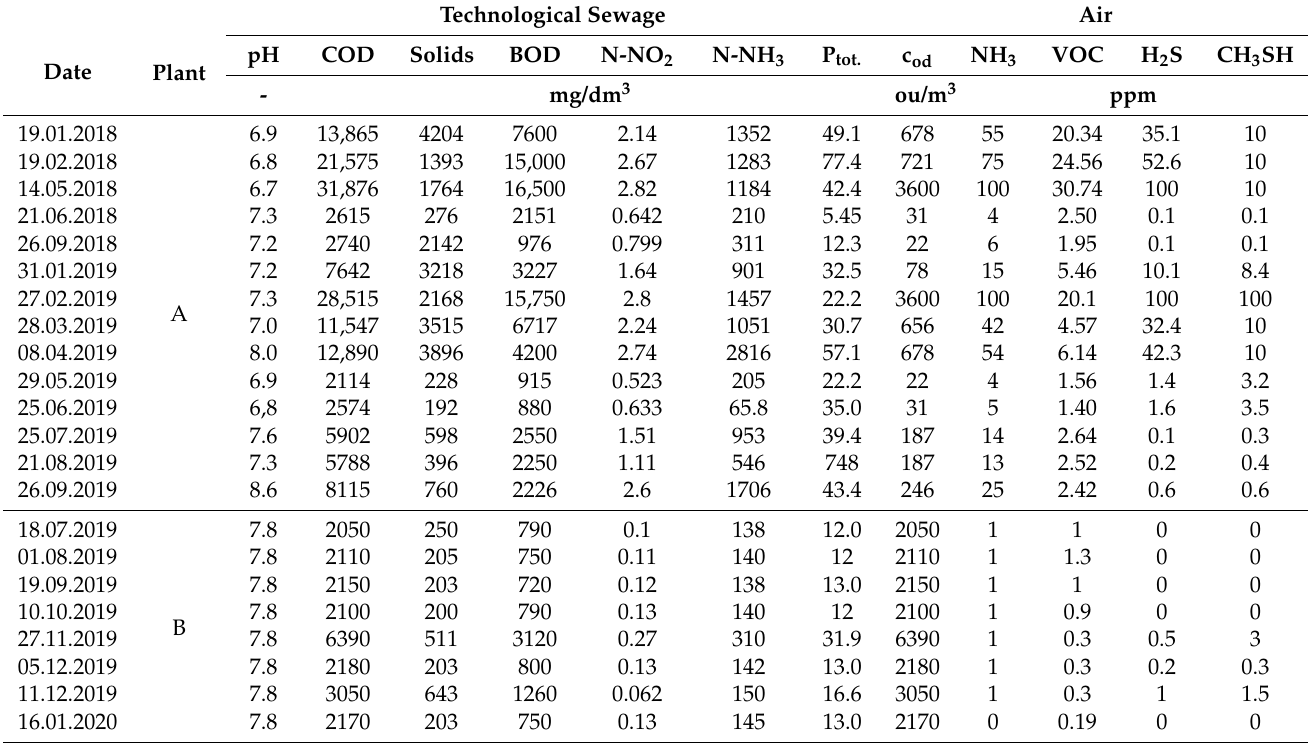
Table 1. Results of technological wastewater and air compounds determinations in biogas plants A and